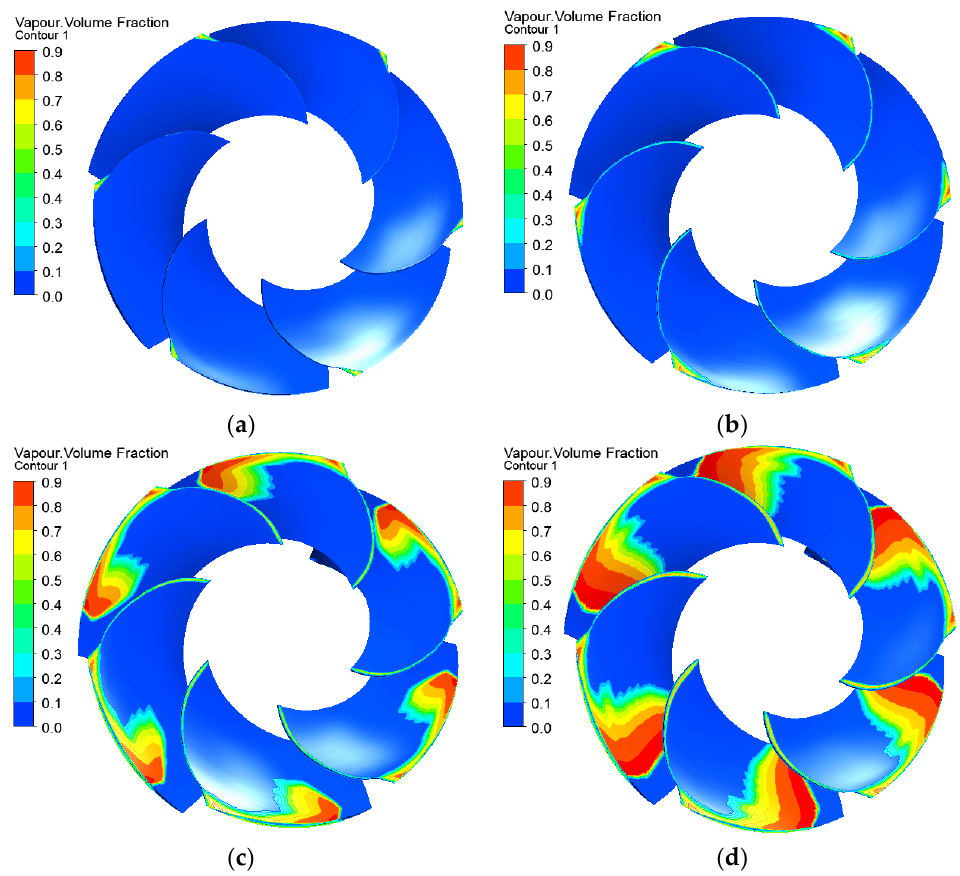
Figure 5. Vapor-filled cavities on the backside of impeller blades at different NPSH values (CFD calculation, blade system № 1, Q = Q BEP ): ( a ) NPSH = 4.8 m; ( b ) NPSH = 2.74 m; ( c ) NPSH = 1.9 m; ( d ) NPSH =NPSH3 = 1.7 m.